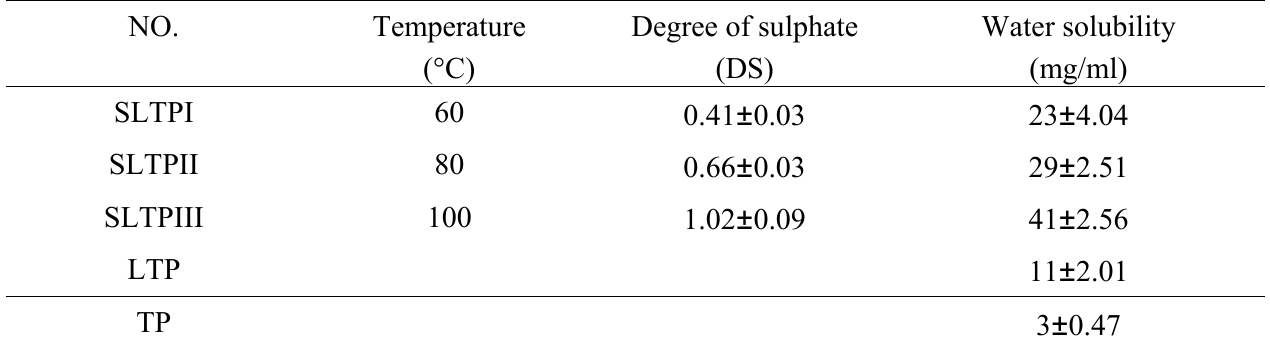
Table 1. Sulfation and water solubility of SLTP, LTP and